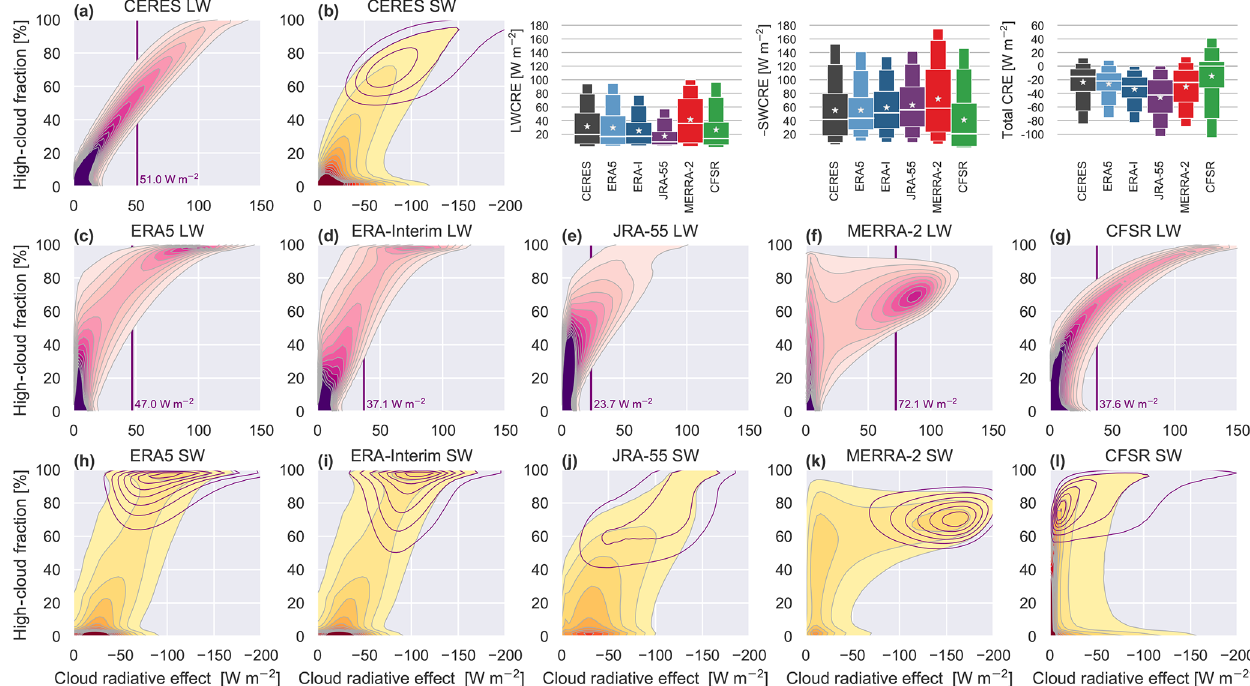
Figure 7. Joint distributions of daily-mean HCC against (a) LWCRE and (b) SWCRE based on CERES SYN1Deg using gridded data from 2001 to 2010. Corresponding joint distributions are shown for (c, h) ERA5, (d, i) ERA-Interim, (e, j) JRA-55, (f, k) MERRA-2, and (g, l) CFSR. The 75th percentile of LWCRE is marked in (a) and (c–g) . Sub-distributions of HCC against SWCRE associated with the values of LWCRE that exceeded the corresponding 75th percentile threshold are then shown as purple contours in (b) and (h–l) . Distributions of LWCRE, SWCRE, and total CRE are shown in the upper right (in which ERA-Interim is abbreviated ERA-I), with SWCRE multiplied by − 1 for convenience of presentation. The thickest boxes mark the interquartile ranges, with the medians marked as horizontal lines and the means marked as stars. The narrower extended boxes indicate the 5th, 10th, 90th, and 95th